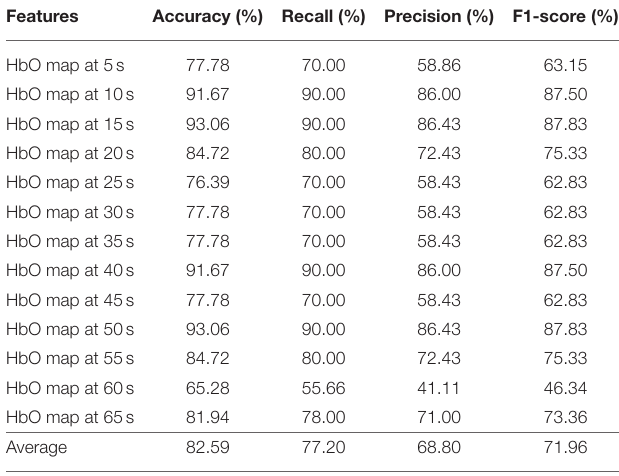
TABLE 4 | Convolutional neural network classification results of neuroimaging with spatial features for the N -back task. Features